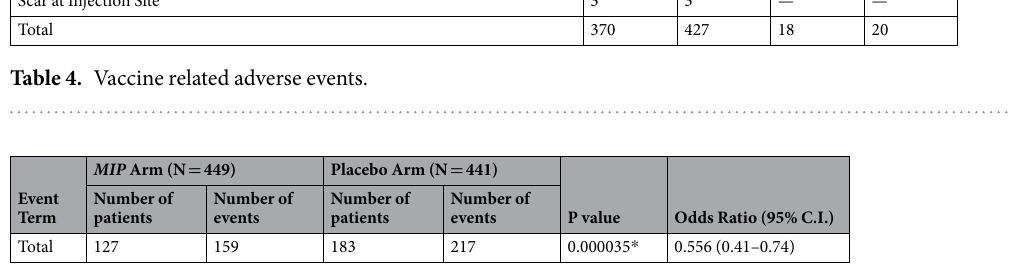
Table 5. Non-Vaccine related adverse events. * p value significant after Boneferroni’s